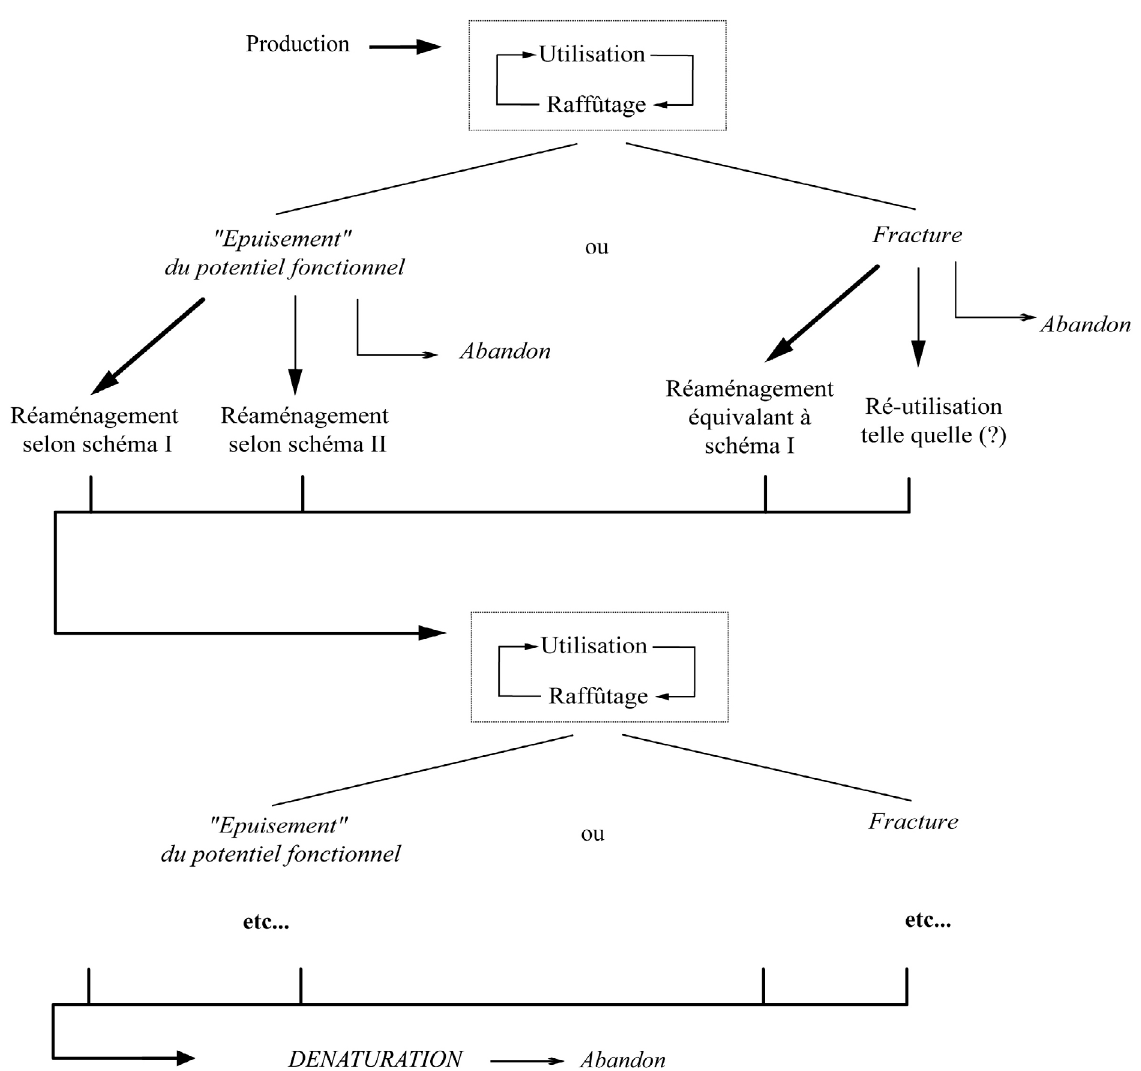
Figure 13. Représentation théorique des étapes par lesquelles passent les pièces façonnées unifacialement au cours de leur vie utile, depuis leur première utilisation jusqu’à leur dénaturation. Figure 13. Theoretical diagram of stages through which unifacially shaped artefacts have gone along their use- life, since the first use to